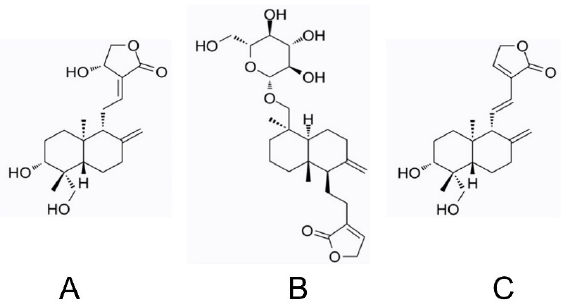
Figure 1. Chemical structures of andrographolide—AND ( A ), neoandrographolide—NAND ( B ), 14-deoxy-11,12-didehydroandrographolide—DAND ( C and 14-deoxy-11,12-didehydroandrographolide—DAND ( C ). A. paniculata extract, at either 1200 [11] or 1800 mg [12] daily, has been shown effec-